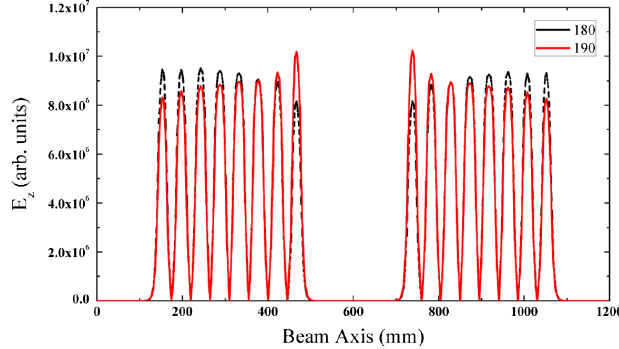
FIG. 29. The dependence of the field distribution as a function of the radius of the coupling cell.